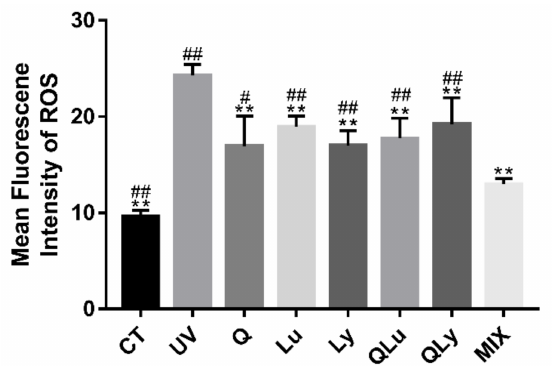
Figure 2. The mean fluorescence intensity (MFI) results of C.elegans stained by 2 (cid:48) ,7 (cid:48) -dichlorofluorescein show the reactive oxygen species (ROS) levels of every group. These pictures were taken in a 50 × field of view (FITC). The higher the ROS level, the brighter the green fluorescence. All data are mean ± SEM and were analyzed by two-tailed Student’s t -test, n = 7, * p < 0.05, ** p < 0.01 compared to UV group. # p < 0.05, ## p < 0.01 compared to MIX group.